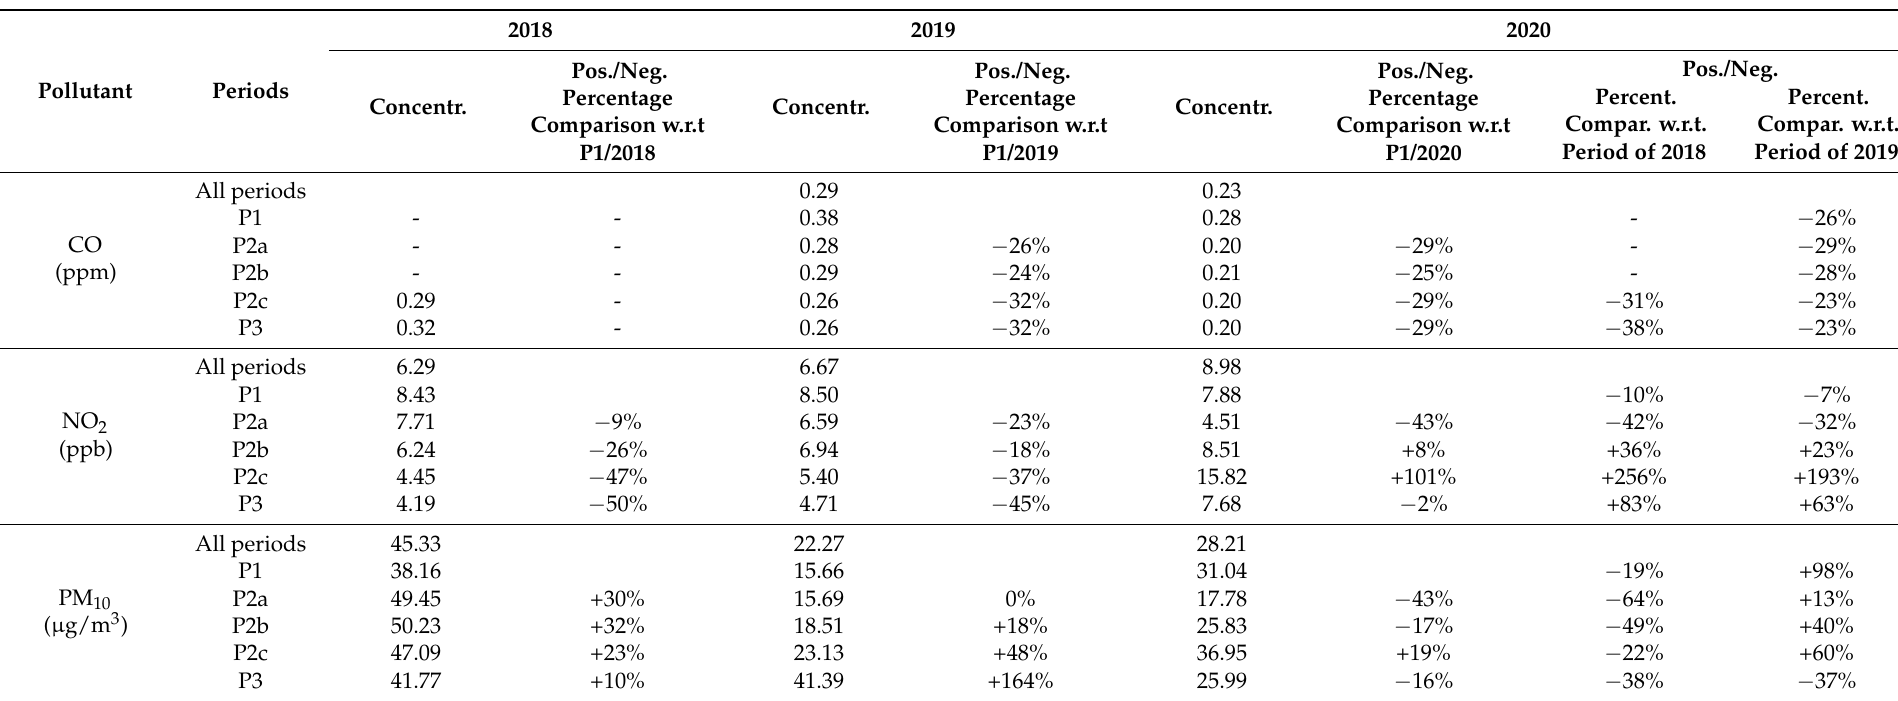
Table 3. Average concentration values for each criterion pollutant (CO (ppm), (NO 2 ) (ppb) and PM 10 ( µ g/m 3 )) during each study period in 2018, 2019 and 2020 as recorded by the AURA station; percentage comparisons as obtained for each subperiod with reference to the P1 subperiod within the same year; and percentage comparisons of the 2020 subperiods with the corresponding subperiod of previous years. Positive percentages denote increase and negative correspondingly